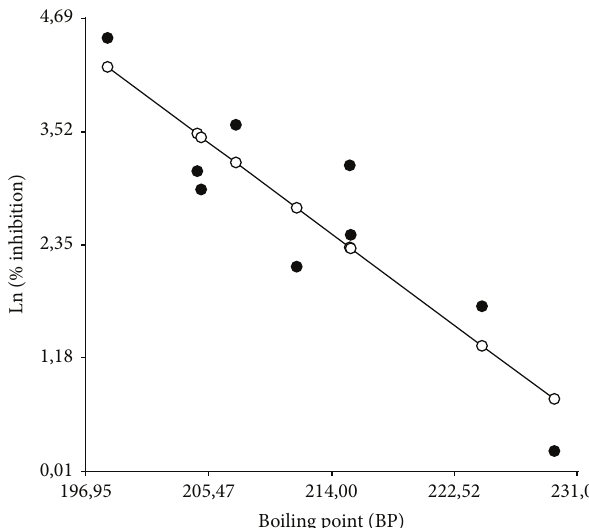
Figure 3: Multiple linear regression analysis (MLR) calculated to examine quantitative relationships between linear combinations of the dependent variable LN (Inhibition%) and the predictor variables (structure and molecular properties). Plot of calculated versus experimental LN (Inhibition%) of ovicidal activity of alcohol and ketone terpenes against